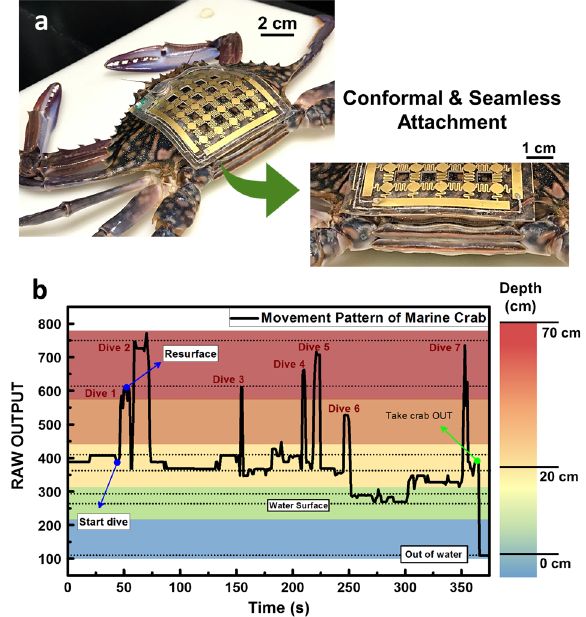
Fig. 5 Field testing on marine animals — crustaceans. a Digital photos of the marine skin system seamlessly attached on the crab using superglue. b Monitoring crab (Portunus pelagicus ) movement in its natural habitat — Depth pattern recognition and animal behavior was actively and continuously recorded in real time with Δ t = 1 s logging